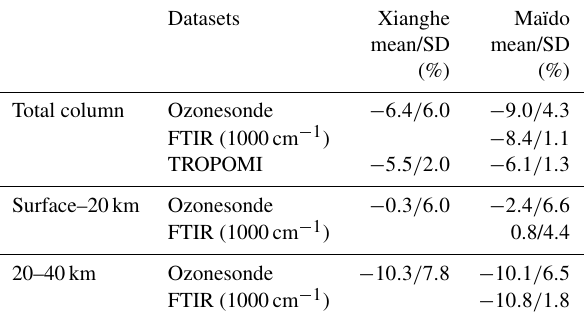
Table 3. The mean and SD (“mean/SD”) of the relative differences between the FTIR O 3 (3040cm − 1 ) retrievals with other datasets (ozonesonde, TROPOMI and FTIR O 3 (1000cm − 1 retrievals)) in total column and two partial columns (surface–20km and 20– 40km) at Xianghe and Maïdo. The relative difference is calculated as ( FTIR − other )/ other × 100%.